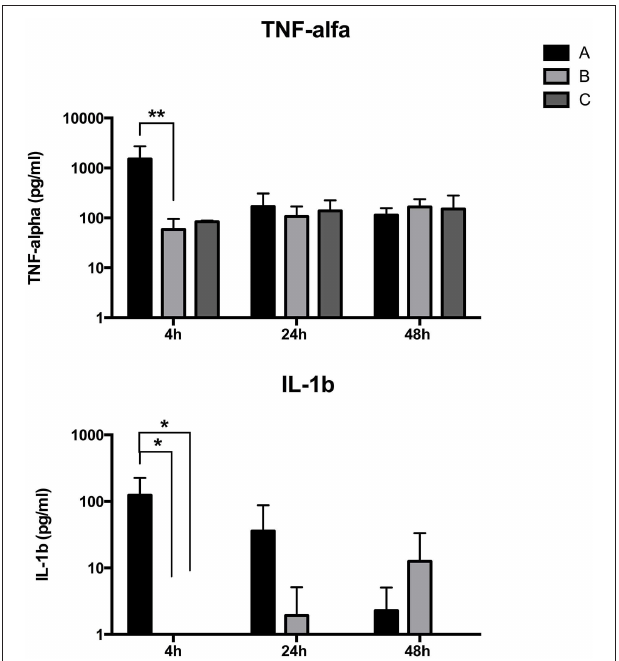
FIGURE 4 | LPS-treated piglets show an increased inflammation 4h post STM14028 infection. IL-1beta and TNF-alpha production was measured at different time points on blood samples from three different groups of piglets: treated with LPS and infected with STM14028 (group A); only STM14028 infected (group B); naïve control group (group C). At 4h post infection, group A showed a significant increase in production of both cytokines compared to the B and C groups. The differences between the groups were statistically significant ( * P ≤ 0.1 ; ** P ≤ 0.01 , multiple comparisons-Fisher’s Least Significant Difference test).